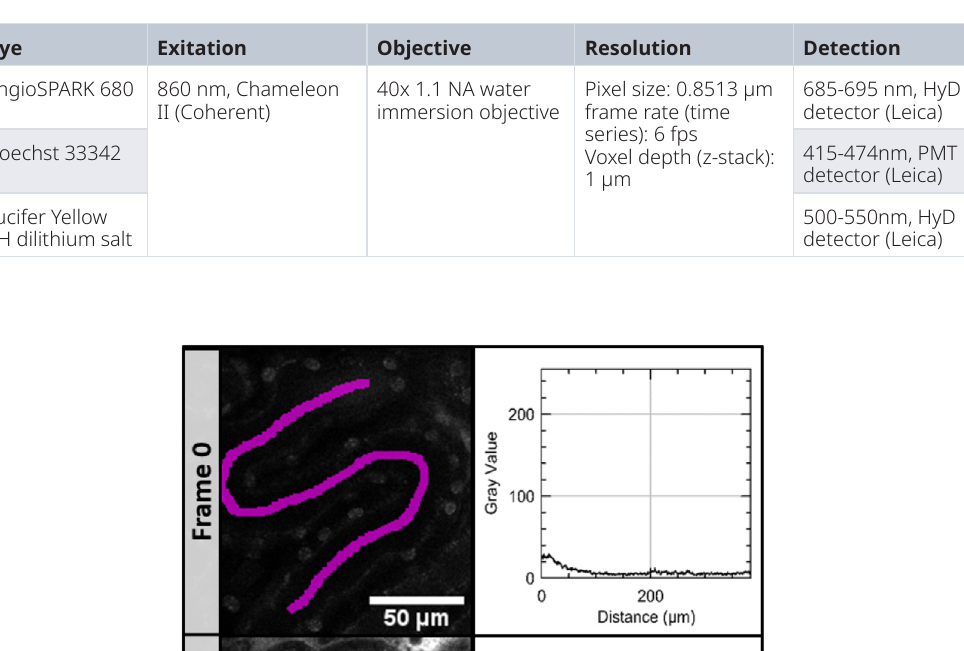
were subtracted plane by plane from Ch2 (target channel,